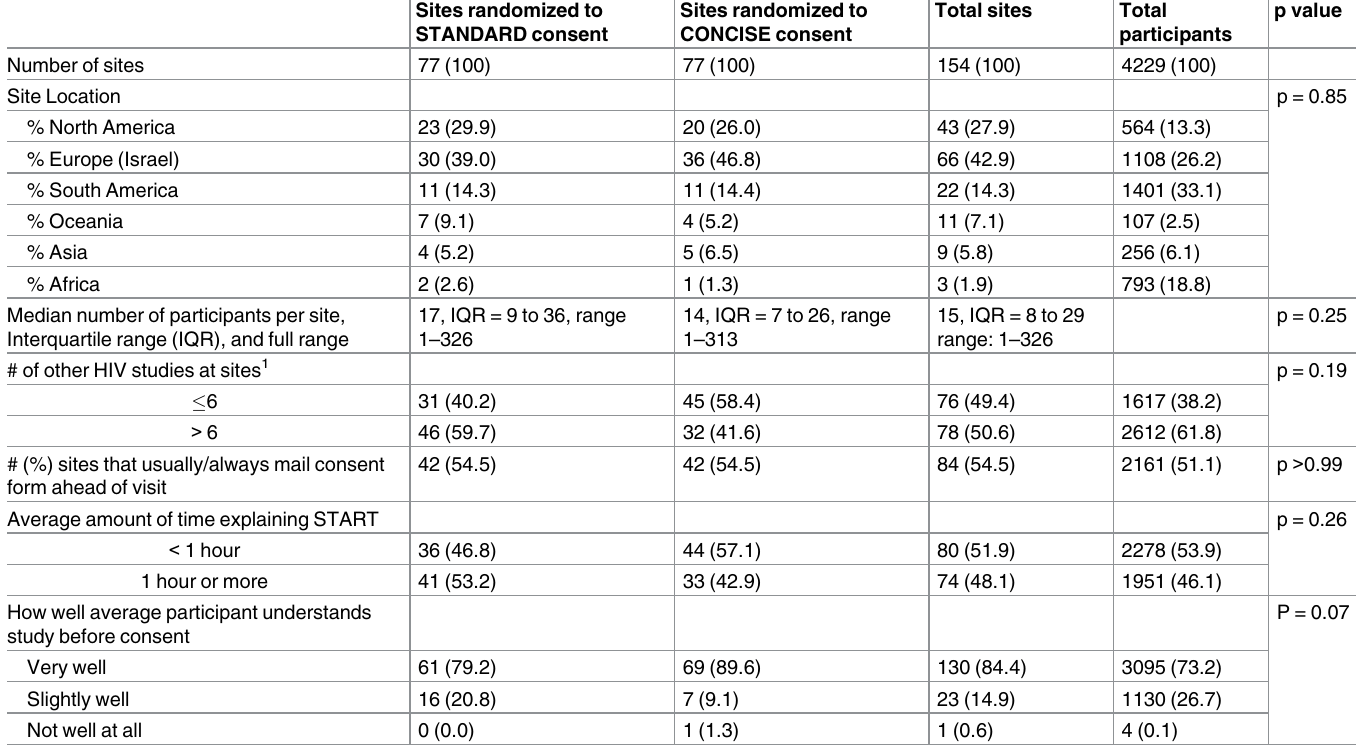
Table 1. Site characteristics by consent